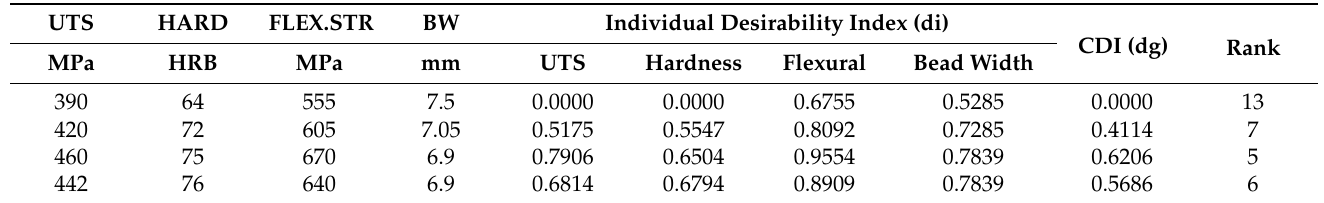
Table 24. Individual desirability index and composite desirability index with its